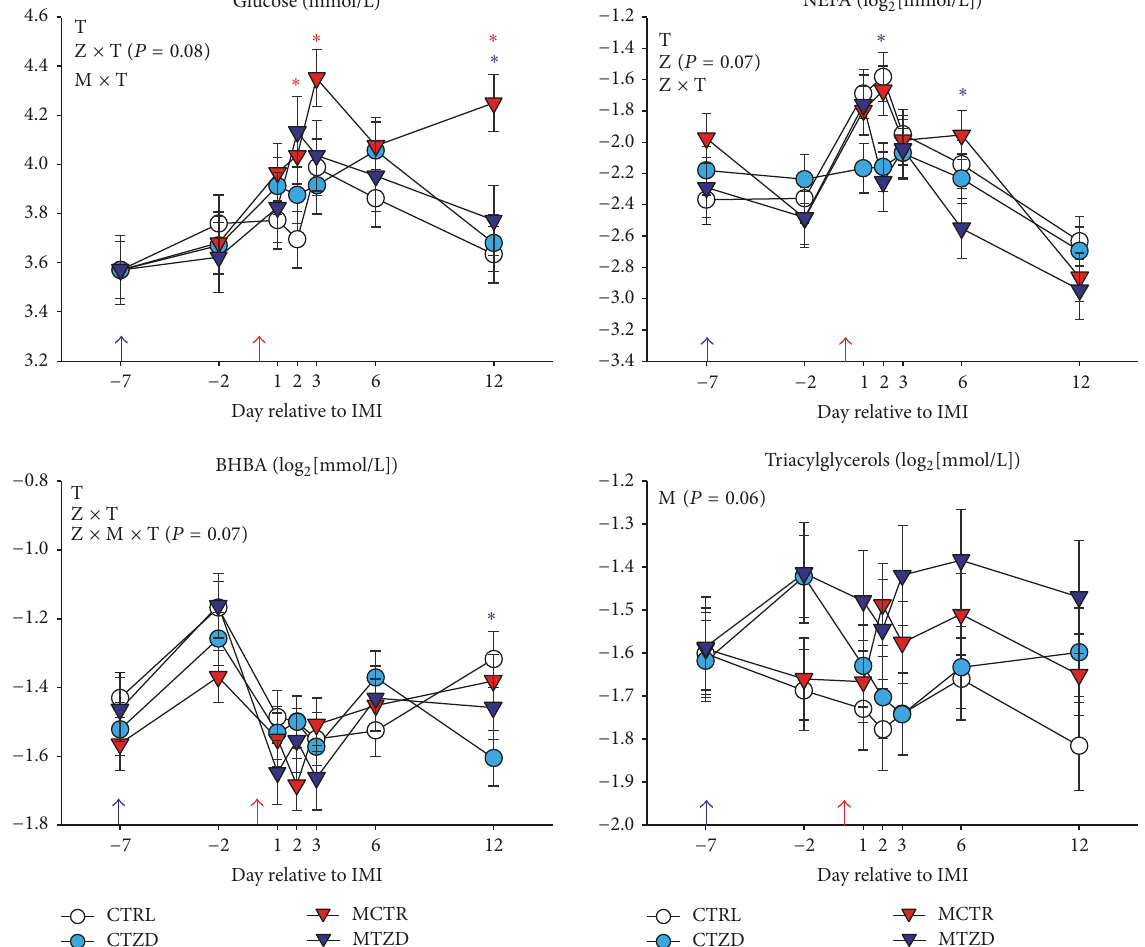
Figure5:Plasmaconcentrationofbloodmetabolicparametersfrom − 7to12drelativetointramammaryinfusionof Strep.uberis (M)orsaline in goats receiving daily intrajugular injection of 2,4-thiazolidinedione (TZD) or saline (CTR). Significant ( 𝑃 ≤ 0.05 ) effects and interactions are indicated in the graph (mastitis: M, time: T, and TZD: Z). The 𝑃 value for tendency is reported. Significant effect of M × T is denoted with red asterisk and effect of Z × T is denoted with purple